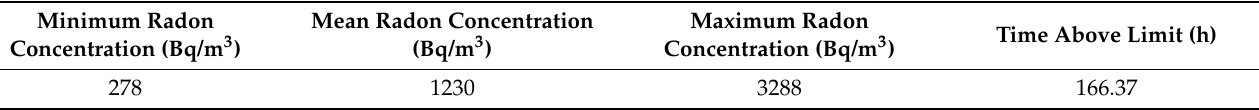
Table 1. Statistics for the radon concentration during a week without the air quality control system activated